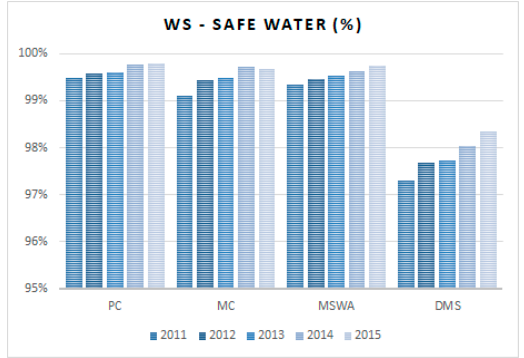
Figure 12. Evolution of the safe water indicator.